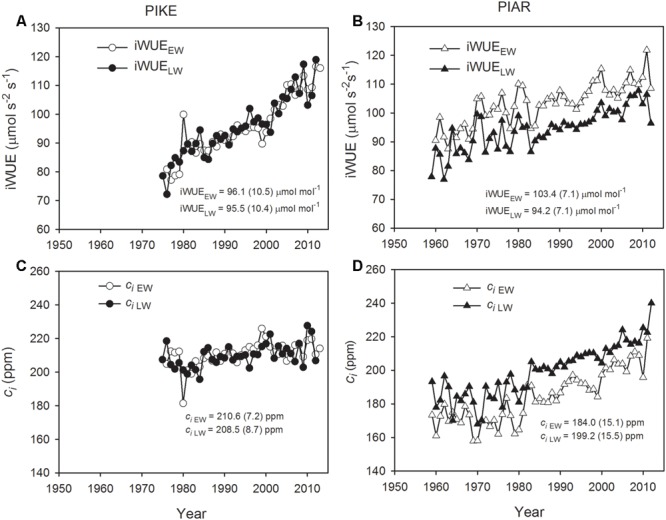
Intrinsic water use efficiency (iWUE) for earlywood (iWUEEW, open circle) and latewood of secondary forest pine P. kesiya (PIKE) (iWUELW, closed circle) (A), and for earlywood (iWUEEW, open triangle) and latewood of natural forest pine P. armandii (PIAR) (iWUELW, closed triangle) (B), intercellular CO2 concentration (ci) of earlywood (ciEW, open circle) and latewood of secondary forest pine P. kesiya (ciLW, closed circle) (C), and for earlywood (ci
EW, open triangle) and latewood of natural forest pine Pinus armandii (ci
LW, closed triangle) (D). Mean values and standard deviations of iWUE and ci series are indicated inside the panels.